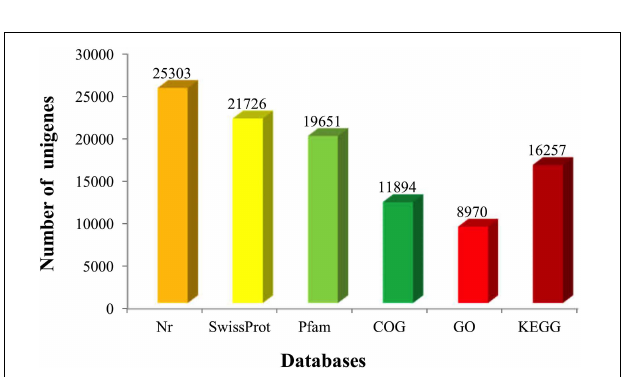
FIGURE 2 | A summary of numbers of annotated unigenes against by six